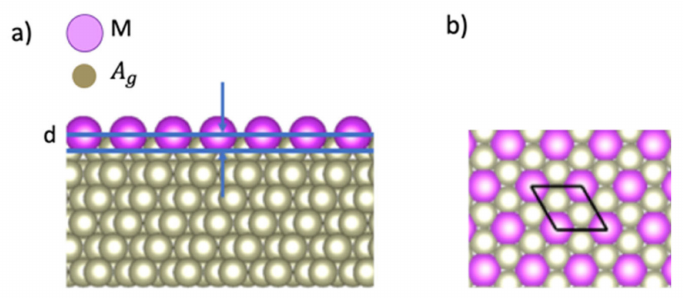
√ (cid:16) √ (cid:17) R 30 ◦ surface alloy. ( a ) Side view. d denotes the 3 × 3